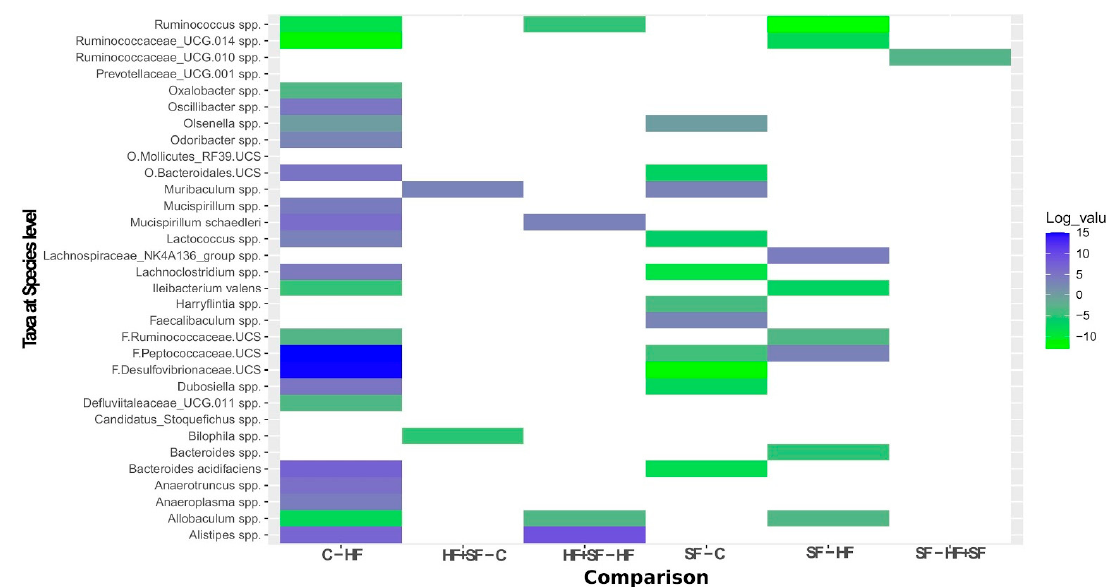
Figure 5. Heatmap representing the 32 significantly differentially abundant taxa at the species level between groups in post samples. The logarithm of only the significant p -values is reported ( p < 0.05), where the values approaching zero are represented as 2.2 × 10 –16 . The sign of the values was transformed to positive or negative according to the direction of the alteration: positive values for increases in the first group within the comparison and negative values for the decreases. Example: A value of 7.218 for Bacteroides acidifaciens when comparing C to HF means that this species is significantly higher in C compared to HF.